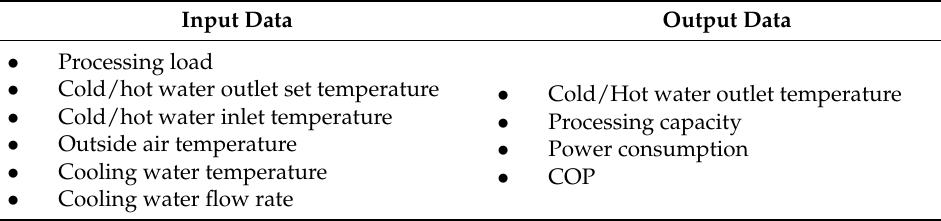
Figure 7. The performance characteristics of the heat pump: ( a ) Cooling performance characteristics; ( b ) Heating performance characteristics. Table 3. The input and output data of the heat source model.